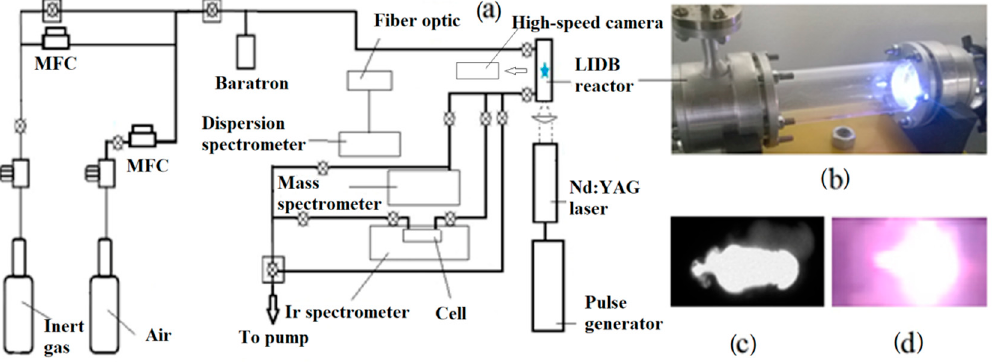
Figure 1. ( a ) Schematic of experimental setup; ( b ) LIDB reactor; ( c ) image of the discharge recorded by camera Nanogate 24/3; ( d ) photograph of the discharge. by camera Nanogate 24/3; ( d ) photograph of the